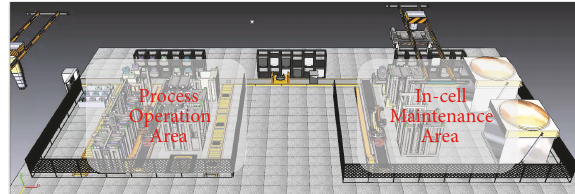
Figure 5: Virtual pyroprocessing hot